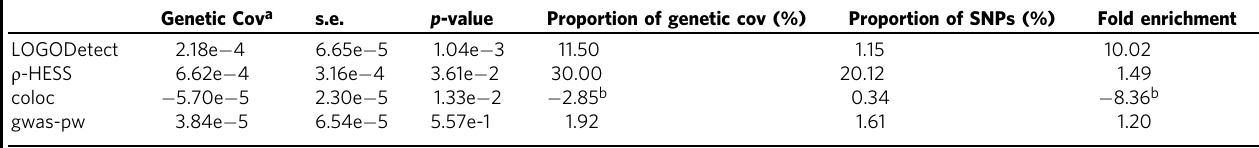
Table 1 Strati fi ed genetic covariance analysis on UKBB replication cohorts. Genetic Cov a